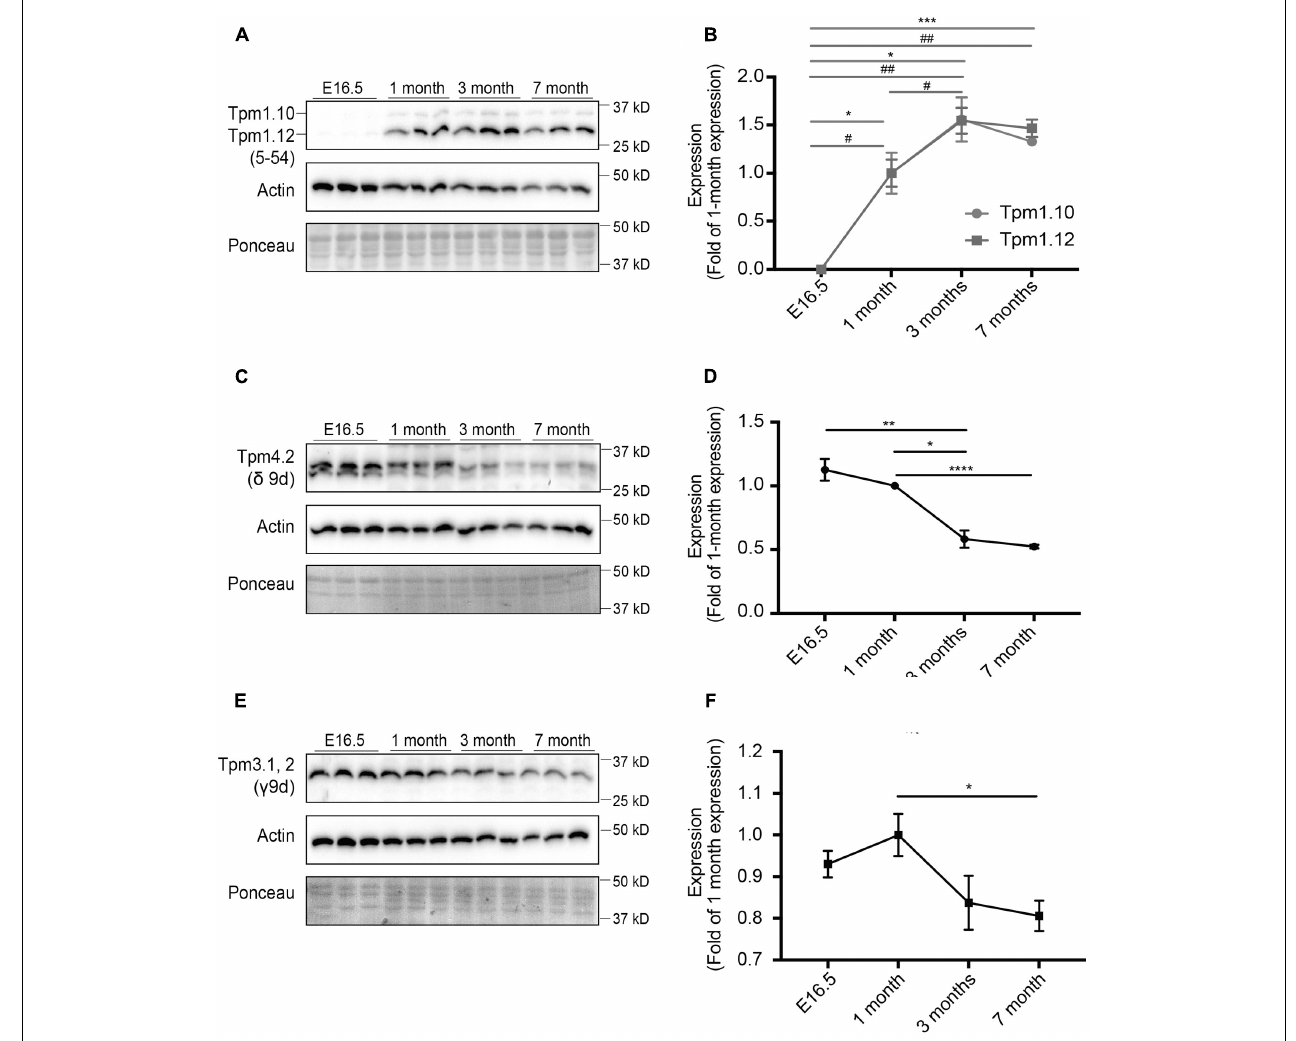
FIGURE 1 | Expression profile of tropomyosin (Tpm) isoforms in the brain throughout development and aging. Western blot analysis and quantification of E16.5, 1, 3, and 7-months-old mouse brain tissue for Tpm expression. (A) Tpm1.10 and Tpm1.12 expression, as detected by the 5–54 antibody. (B) Quantification of expression of Tpm1.10 and Tpm1.12 expression ( ∗ ) indicates significance for Tpm1.10, ( # ) indicates significance for Tpm1.12. (C) Expression of Tpm4.2 as detected by the δ 9d antibody. (D) Quantification of (C) . (E) Expression of Tpm3.1, 2, as detected by the γ 9d antibody. (F) Quantification of (E) . (mean ± SEM, n = 3, ∗ / # P <